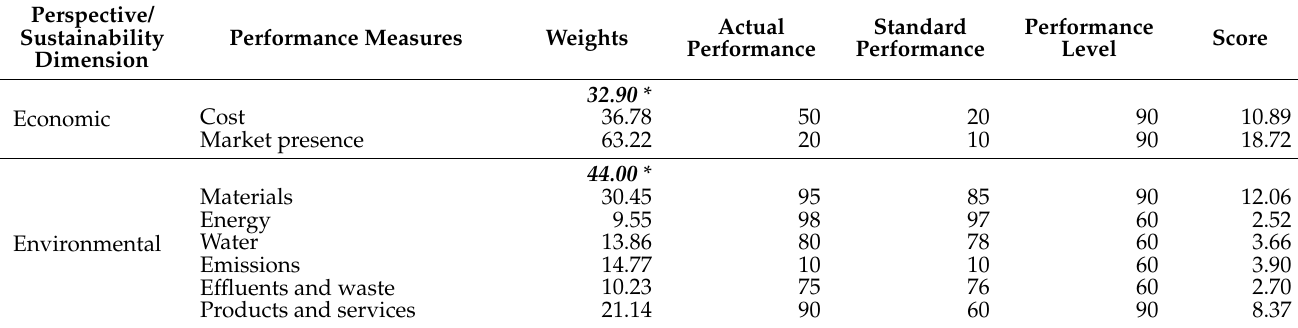
Table 5. BSC for sustainability measurement (modified from